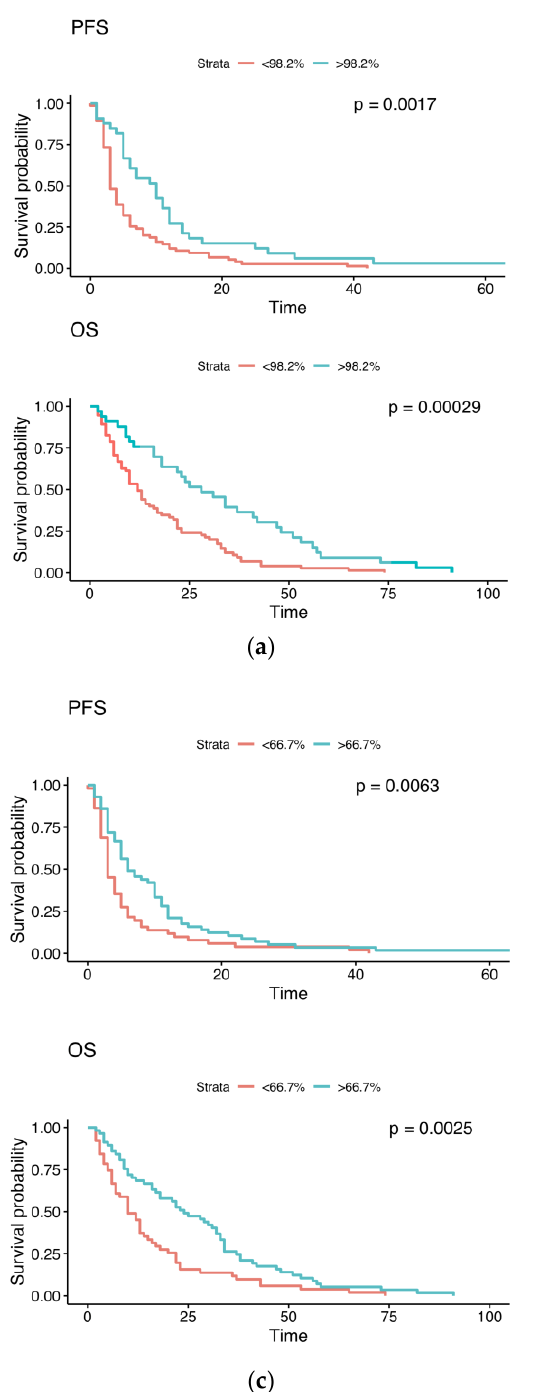
Figure 3. Kaplan–Meier curves representing differences in OS and PFS (in months) between groups with a cut-off of ( a ) a 98.2% iCTC reduction, ( b ) a 50% aCTC reduction, and ( c ) a 66.7% iCTC + aCTC reduction.